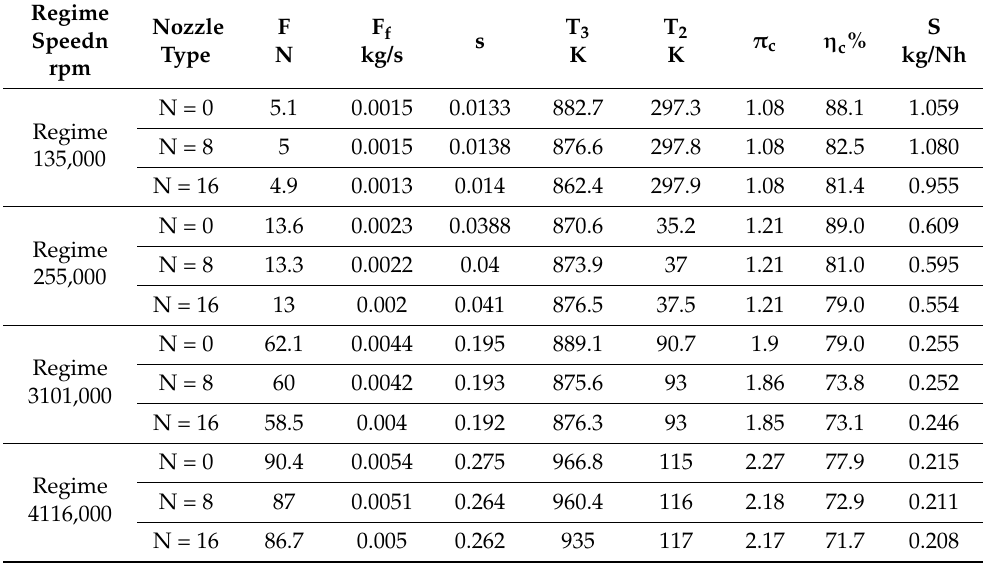
Table 2. Turbojet engine functioning parameters.